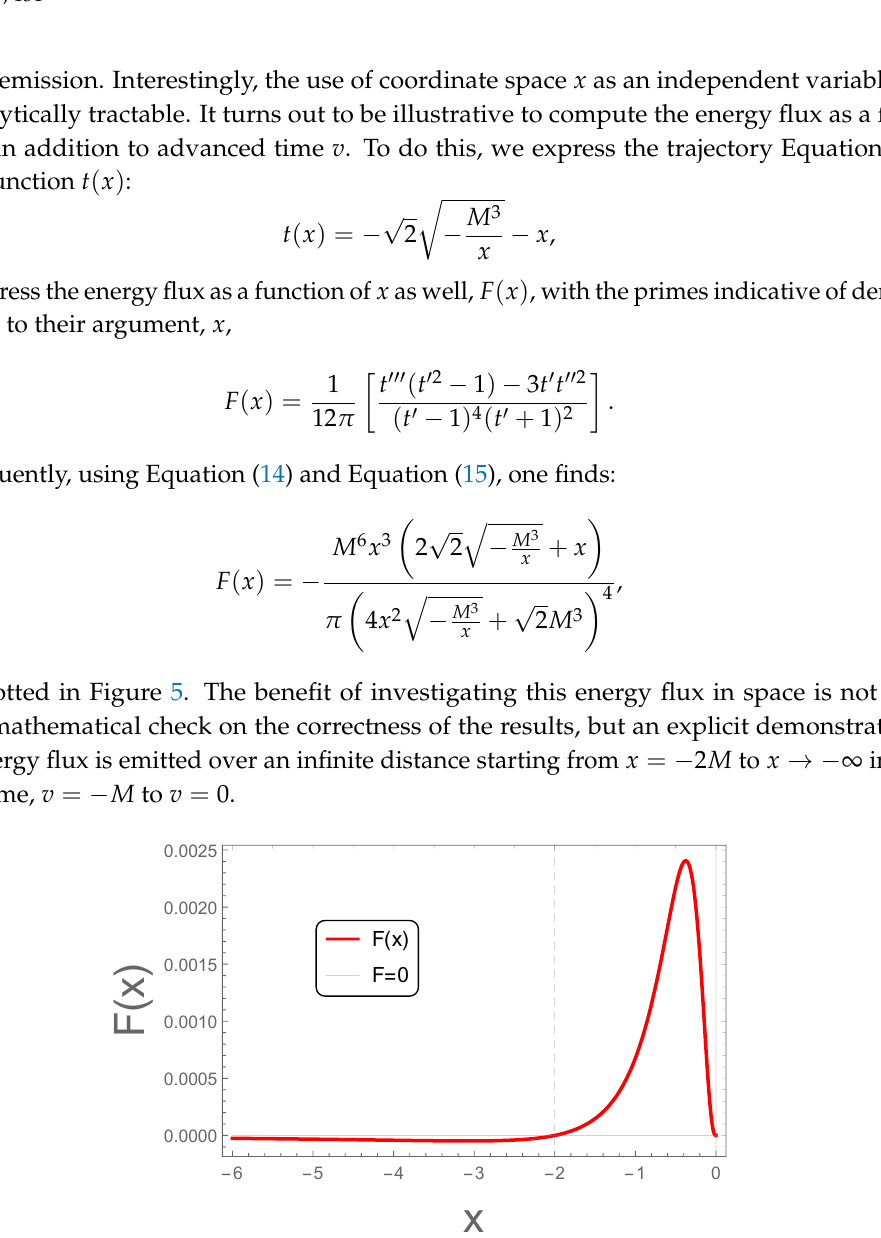
Figure 5. The energy flux, Equation (16), is asymptotically zero at x = − ∞ and x = 0 − . The total energy is finite. Notice the eternal emission of negative energy flux after x > − 2 M . Here M = 1. The energy flux is zero, F ( − 2 ) = 0 and asymptotic approaches zero again as x → − ∞ . Note that the mirror starts at x = 0 and travels to x = − ∞ , reading the evolution from right to